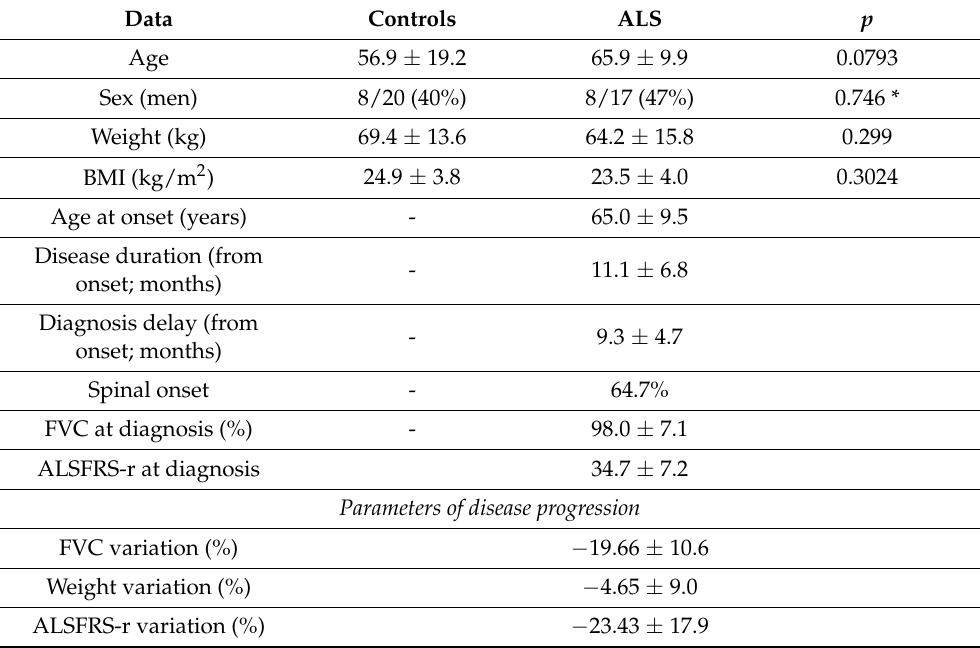
Table 1. Clinical characteristics of ALS patients and control